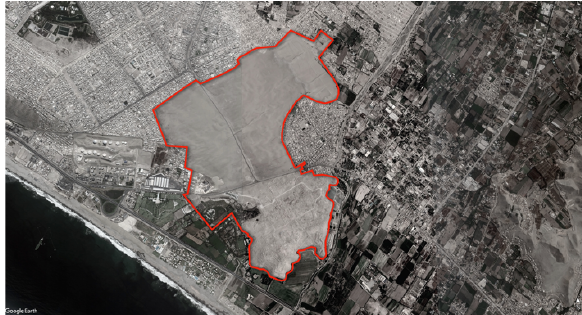
Figure 1 . Footprint of the archaeological site of